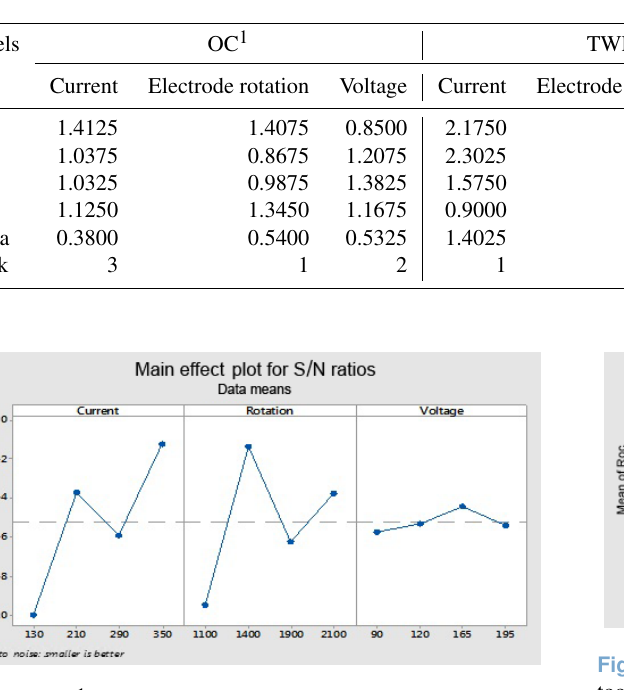
Figure 14. Ra 1 S/N for the cryogenic tool.